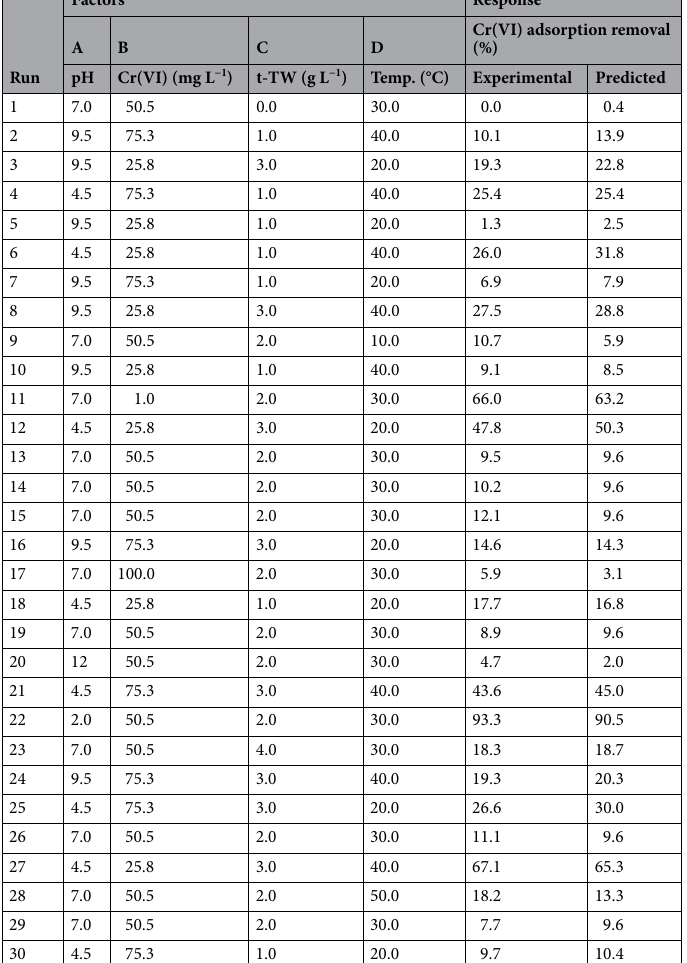
Table 2. Experimental design matrix and response of experimental settings for the adsorptive removal of Cr(VI) by tea waste treated with ascorbic